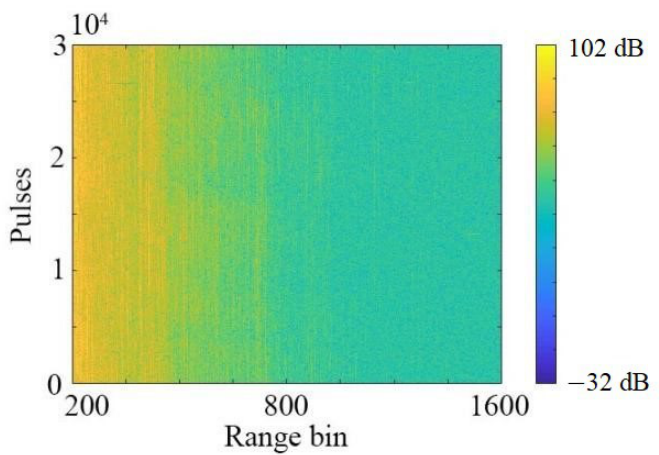
Figure 1. Real sea clutter data.